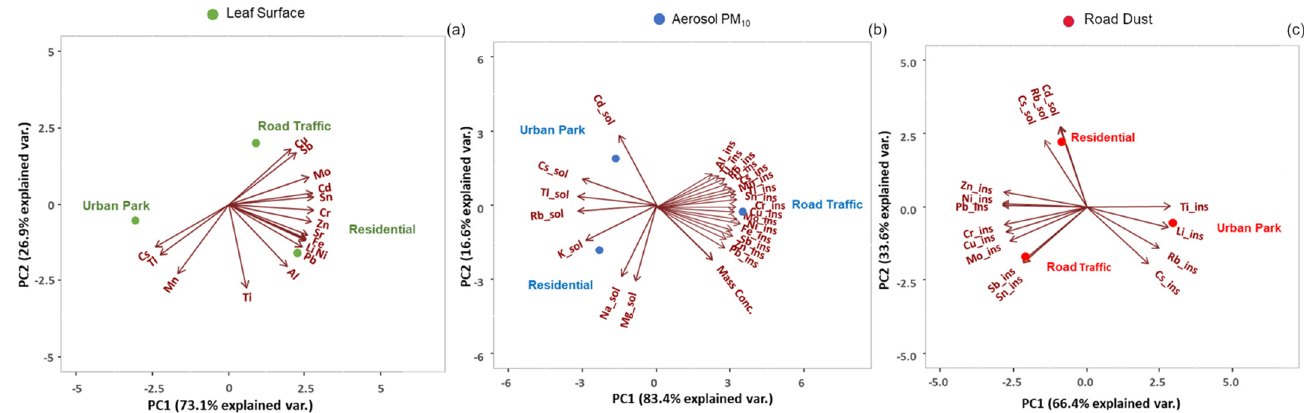
Figure 7. Principal Component Analysis of the selected elemental components detected in the three types of samples ( a ) leaf surface, ( b ) Aerosol PM 10 and ( c ) Road Dust at the three sampling sites of Rome.